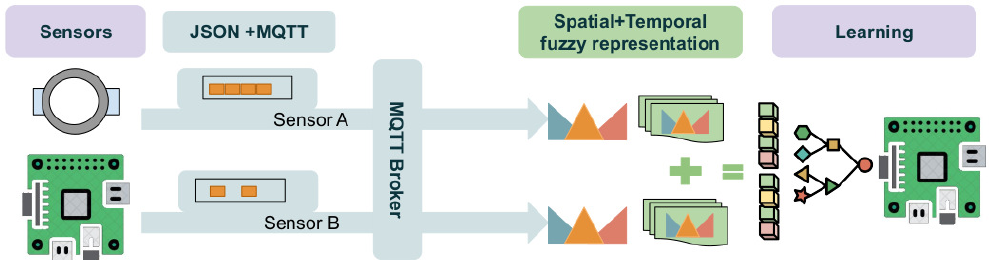
Figure 3. Fuzzy fusion of spatial-temporal features of sensors: (i) data from the heterogeneous sensors are distributed in real time; (ii) fuzzy logic processes spatial-temporal features; (iii) a light and efficient classifier learns activities from the